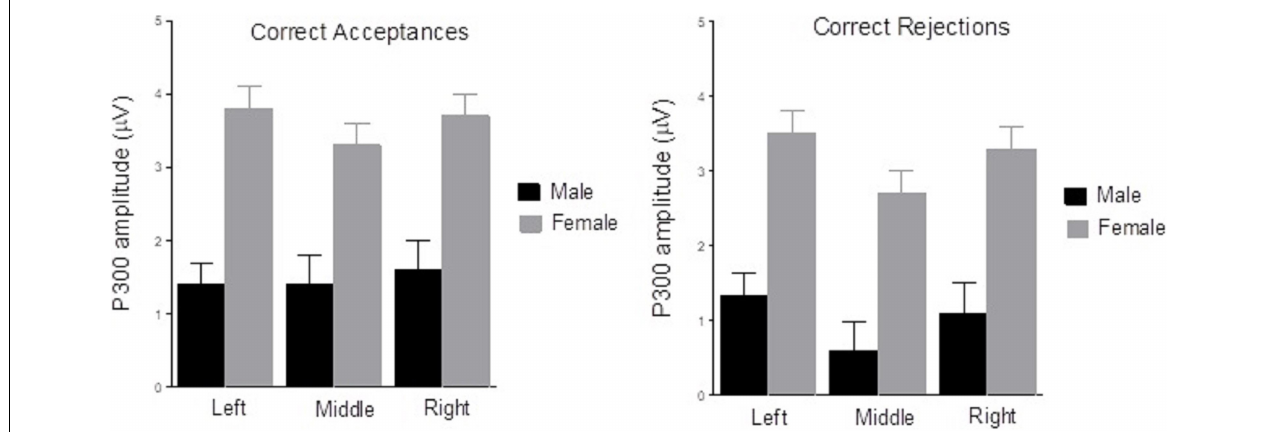
FIGURE 9 | Mean of P300 amplitude (in mV) of Hits (left graph) and Correct Rejections (right graph) as a function of Laterality, Left (C3, P3, O1), Middle (Cz, Pz, Oz), and Right (C4, P4, O2), and Sex (male, female), in the Retrieval phase. There was a main effect of Sex ( p < 0.050). Laterality main effect was found only in Correct Rejections, p = 0.002. There were significant differences between Left and Middle laterality, p = 0.001; and Middle and Right laterality, p =